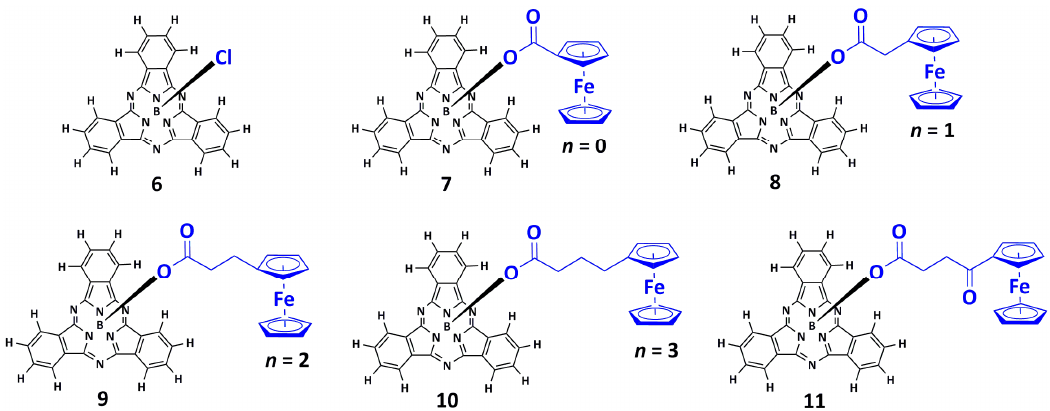
Figure 1. Structures of ClBSubPc(H) 12 , 6 , FcCO 2 BSubPc(H) 12 , 7 [21], FcCH 2 CO 2 BSubPc(H) 12 , 8 (novel), Fc(CH 2 ) 2 CO 2 BSubPc(H) 12 , 9 [24], Fc(CH 2 ) 3 CO 2 BSubPc(H) 12 , 10 (novel) and FcCO(CH 2 ) 2 CO 2 BSubPc(H) 12 , 11 (novel), containing Cl or the ferrocenylcarboxylic acids FcCO 2 H ( 1 ), FcCH 2 CO 2 H ( 2